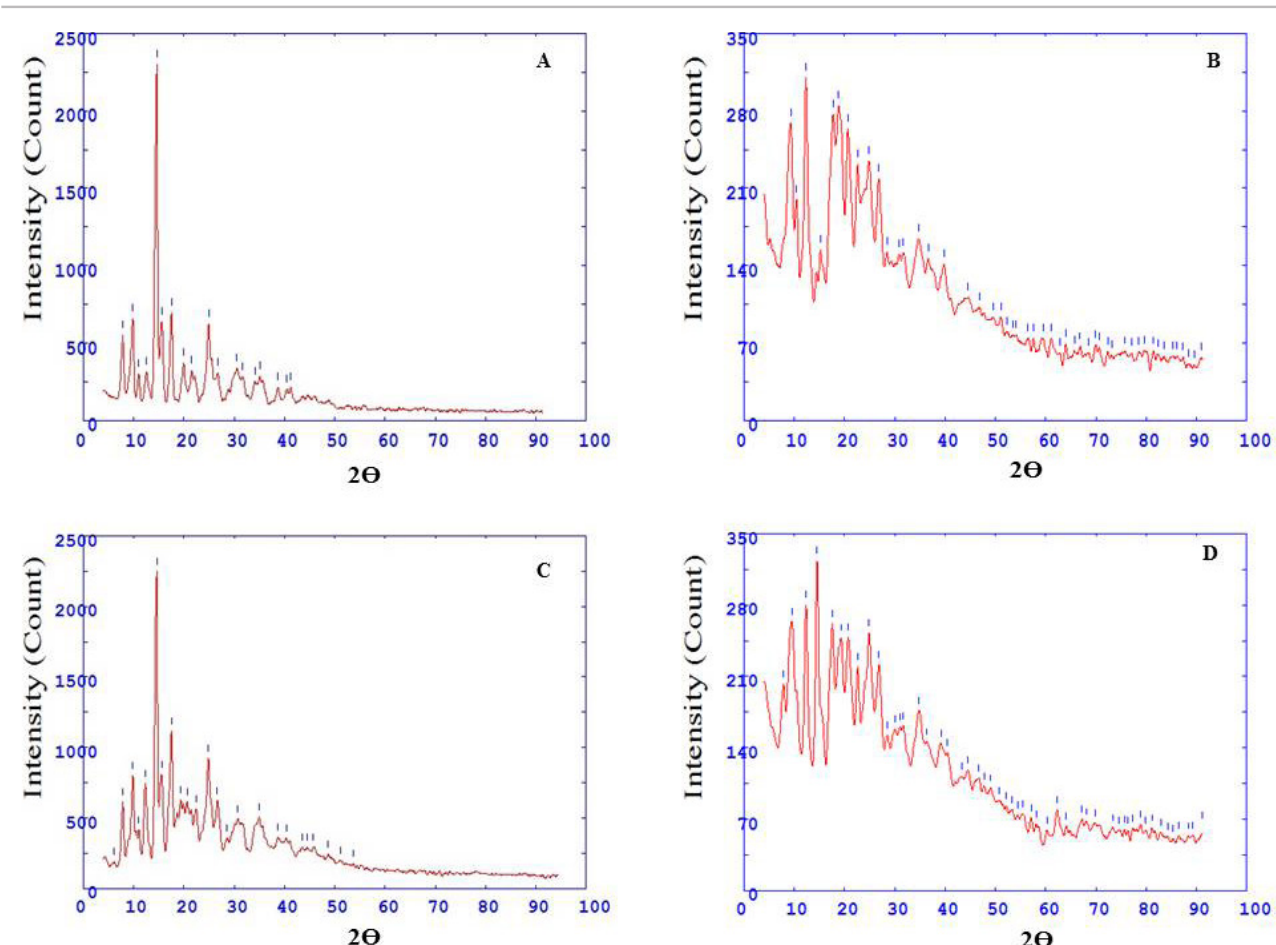
FIGURE 3 - PXRD patterns of (A) Eplerenone, (B) β-CD, (C) physical mix., (D) inclusion complex. *PXRD: powder x-ray